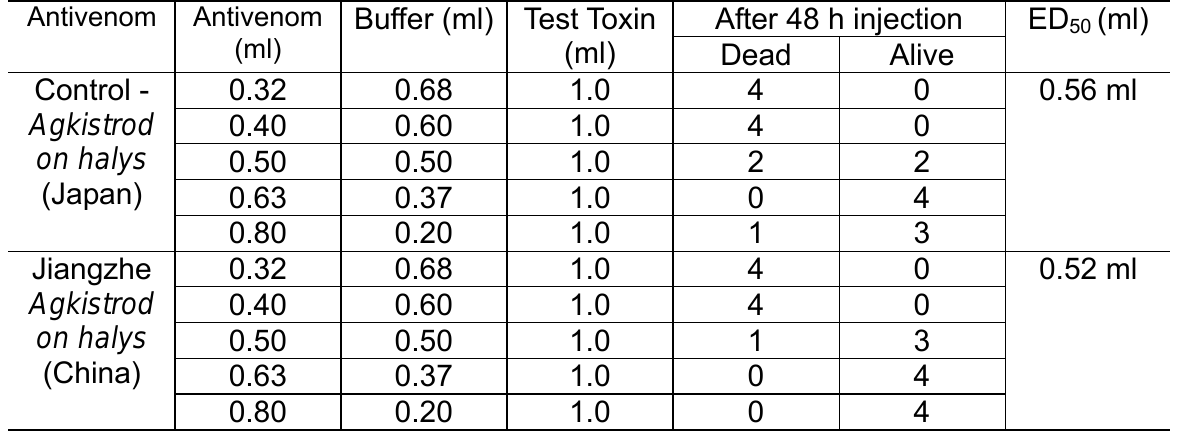
After 48 h injection